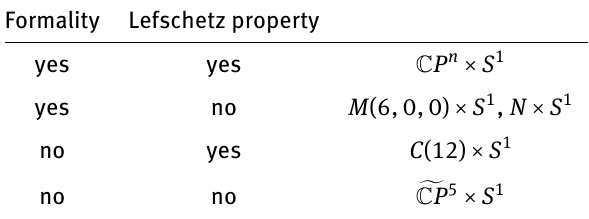
Table 4: Product K-cosymplectic manifolds with b 1 = 1